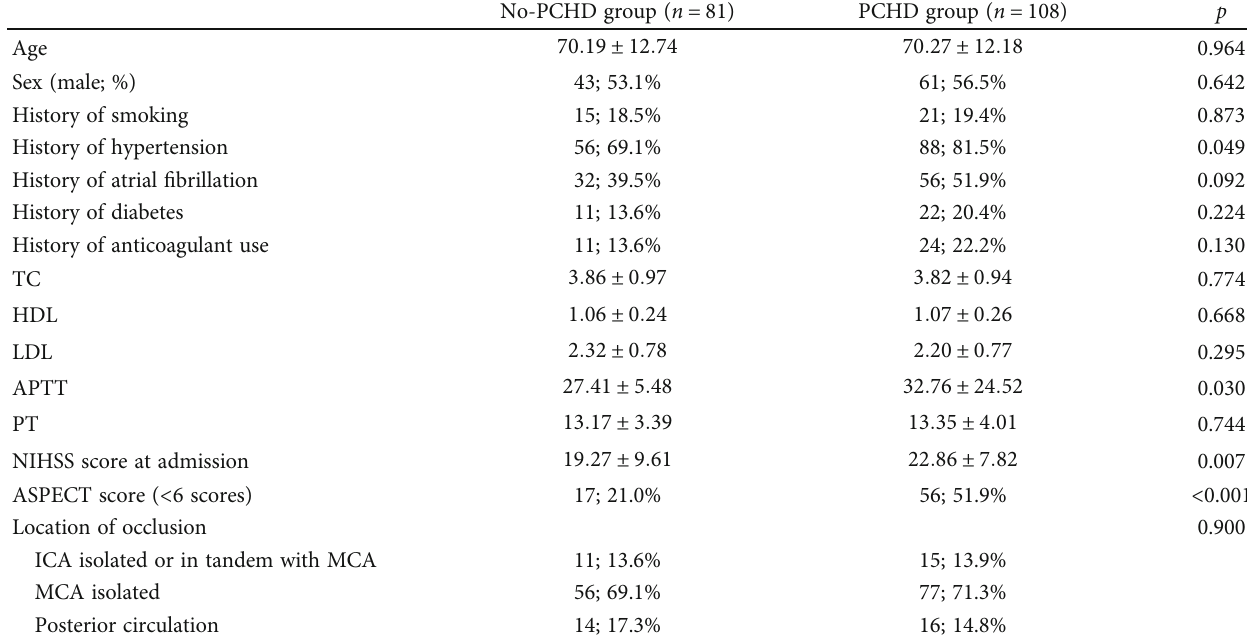
Table 1: Basic characteristics of the no-PCHD and PCHD